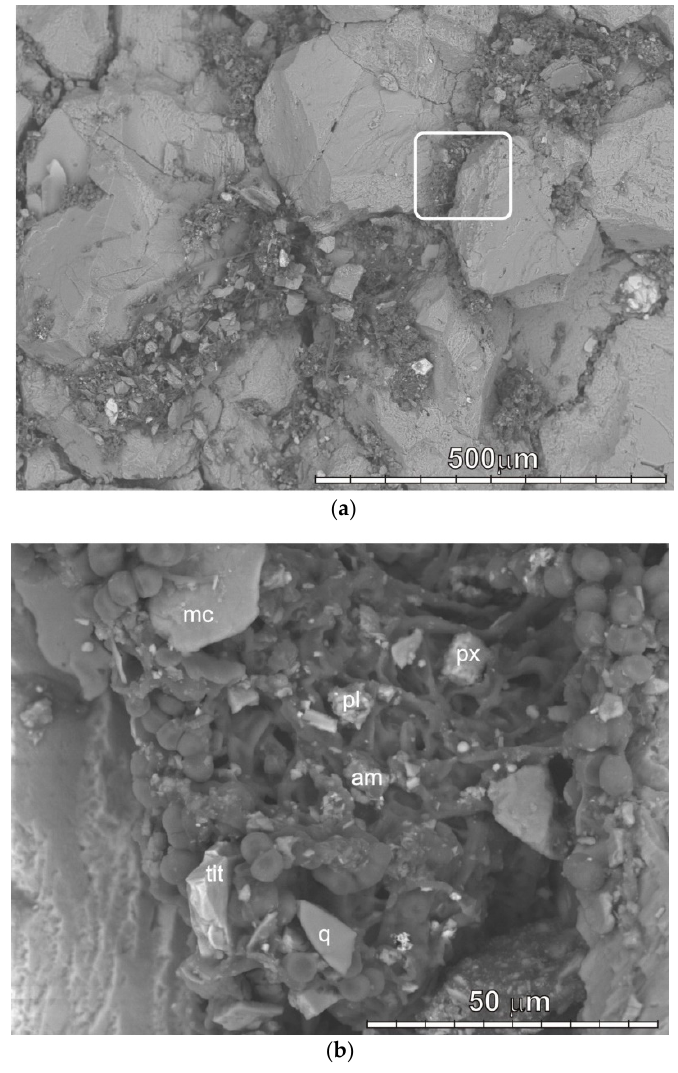
Figure 2. SEM-image of a biofilm with a predominance of microscopic fungi on the surface of a homogeneous calcite marble: ( a )—microcolonies of fungi around calcite grains (the white frame shows the area shown in figure b); ( b )—grains of various silicate minerals among fungal hyphae and rounded cells (in the region shown in Figure 2a): quartz (q), plagioclase (pl), mica (mc), pyroxene (px), Fe—titanite (tit), Pb—amphibole (am). In all the samples of primary soils, in addition to minerals found in biofouling there also are secondary layered silicates present in different proportions: mica (biotite, polytype 1M), magnesian chlorite, and disordered mixed-layer silicate of the mica-montmorellonite